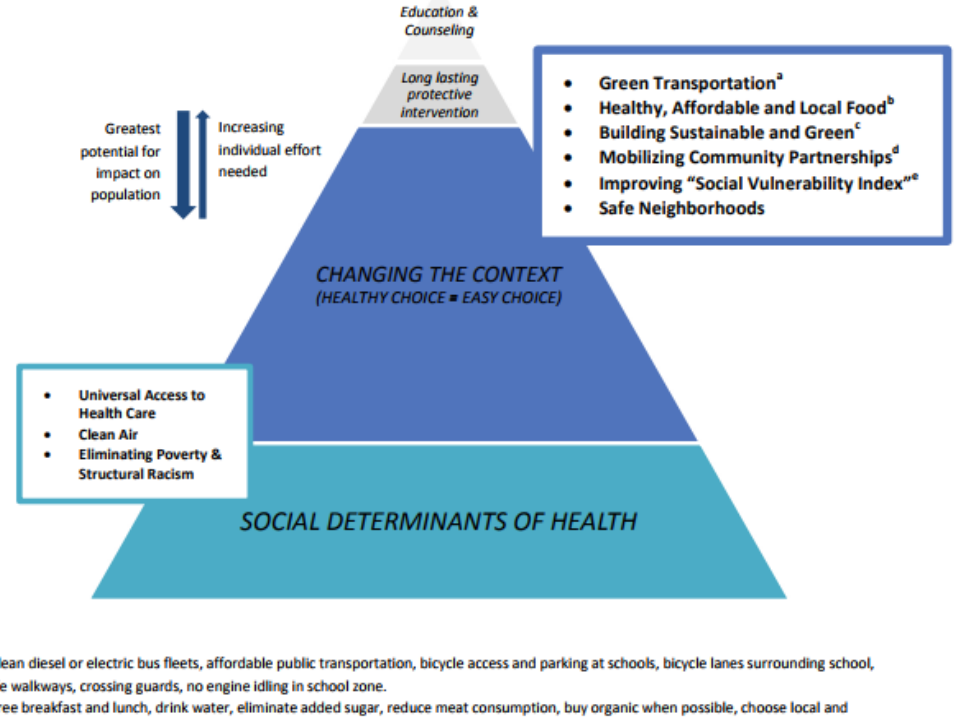
Figure 2. Health Impact Pyramid with climate change preparedness efforts that influence schools or the communities in which schools exist (modified from Frieden [80]).